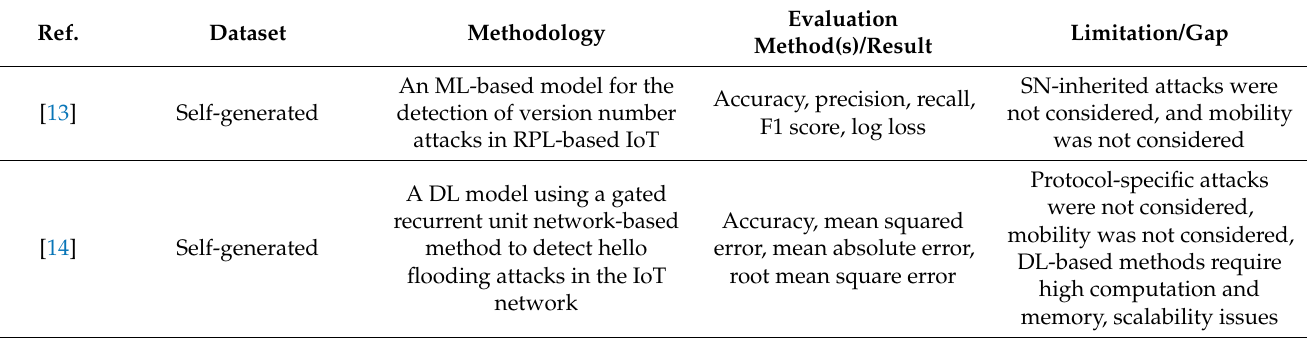
Table 1. Summary of Related Works, Limitations, and Research